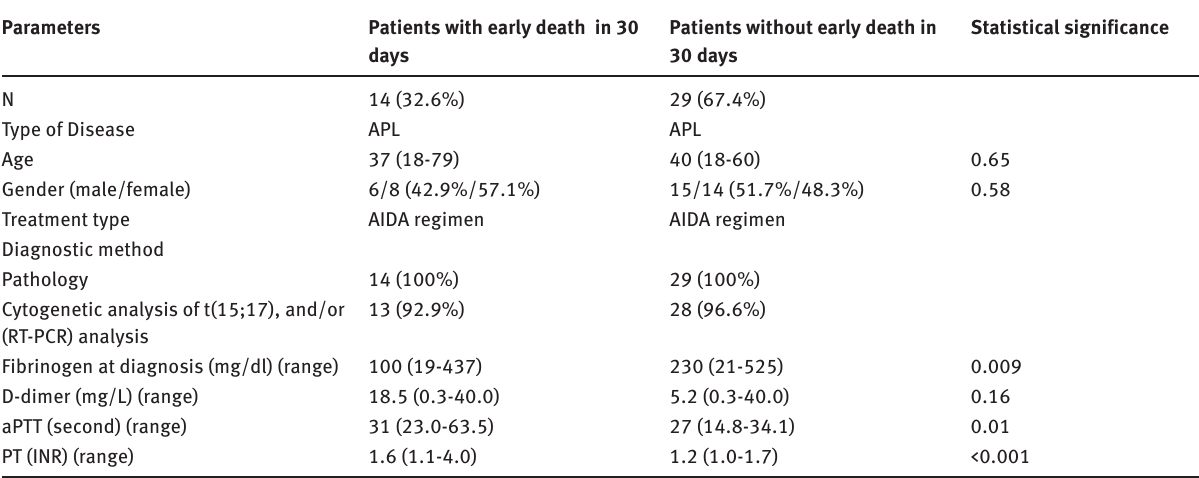
Table 1: Baseline clinical and demographic characteristics of patients